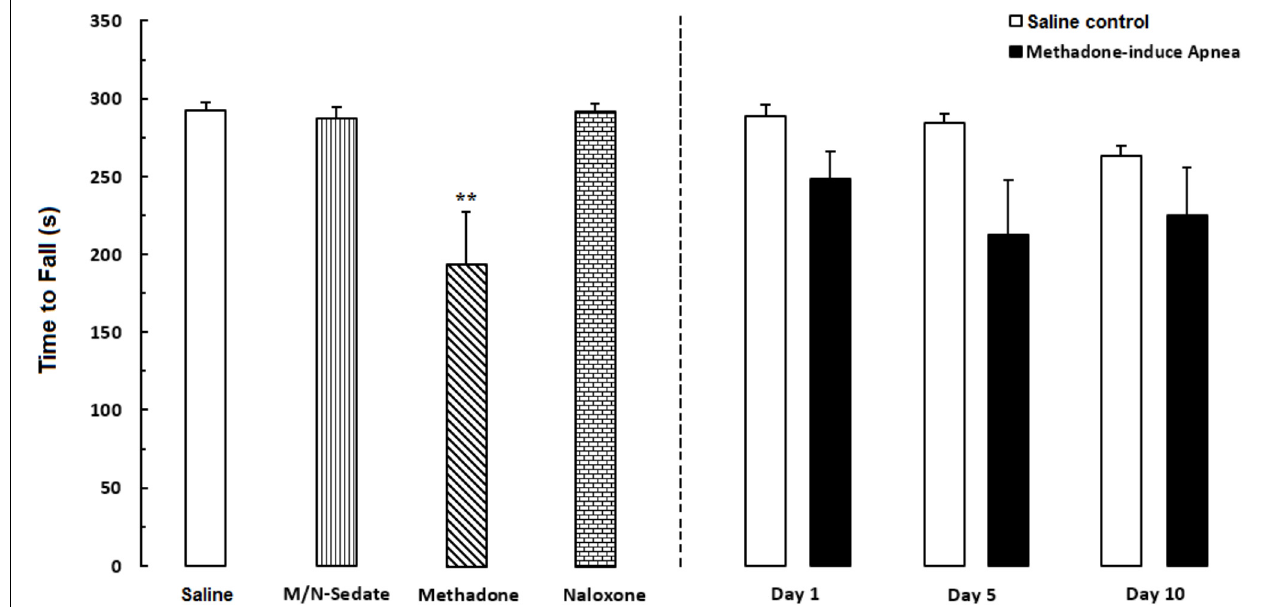
FIGURE 5 | Evaluation of motor coordination and balance in rotarod test during a 5-min trial in different groups, including; M/N-treated groups (a single dose of naloxone was administered after methadone overdose in apnea stage, in animals which experienced apnea and motor coordination was evaluated either on day 1, 5, or 10 day post-resuscitation; M/N-Day 1 ( n = 9), M/N-Day 5 ( n = 6) and M/N-Day 10 ( n = 8) groups and their respective Saline control groups; n = 6; right panel), M/N-Sedate ( n = 8; a single dose of naloxone was administered following methadone overdose, immediately in the initial stage of sedation, so behavioral evaluation was carried out only 1 day after drug administration), Saline; n = 10, methadone; n = 9 and naloxone; n = 6 (saline, methadone or naloxone was administered alone in separated groups in which coordination assessment was evaluated only 24 h following the drug administration in a 5-min trial in adolescent rats) groups. Animals received methadone (15 mg/kg; i.p.) or naloxone (2 mg/kg; i.p.) alone or both in a single dose. The time each rat stay on the rod before falling was recorded. Each bar shows the mean ± SEM for 6–10. ∗∗ P < 0.01 different from the Saline